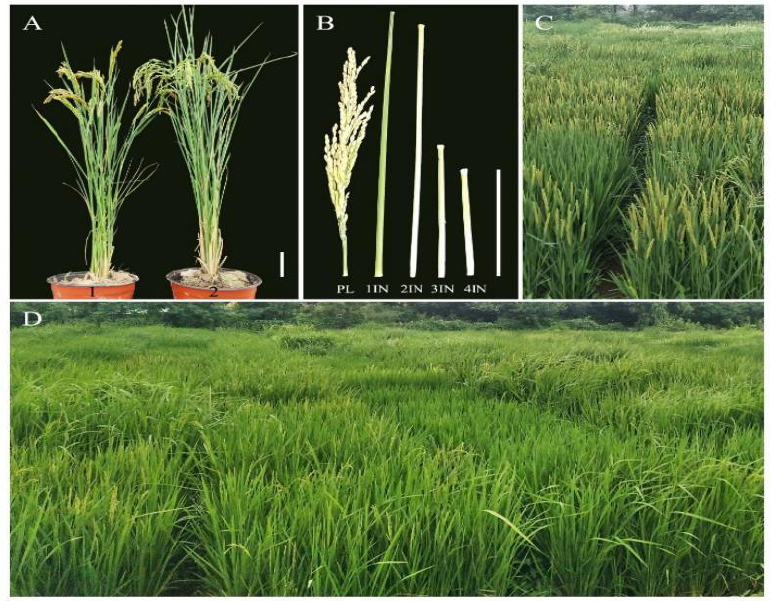
Figure 2. Plants, plant-height traits measurement and partial materials in XC-CSSL population and natural population. ( A ) Plants of Xiushui79 (1) and C-bao (2) (scale bar = 5 cm). ( B ) Measurement of Panicle (PL) and internode length: the upper first (1IN), second (2IN), third (3IN) and fourth (4IN) internodes (Scale bar = 5 cm). ( C ) Partial materials of XC-CSSL population showing differences of plant height among lines. ( D ) Partial varieties of natural population showing differences in the plant height.